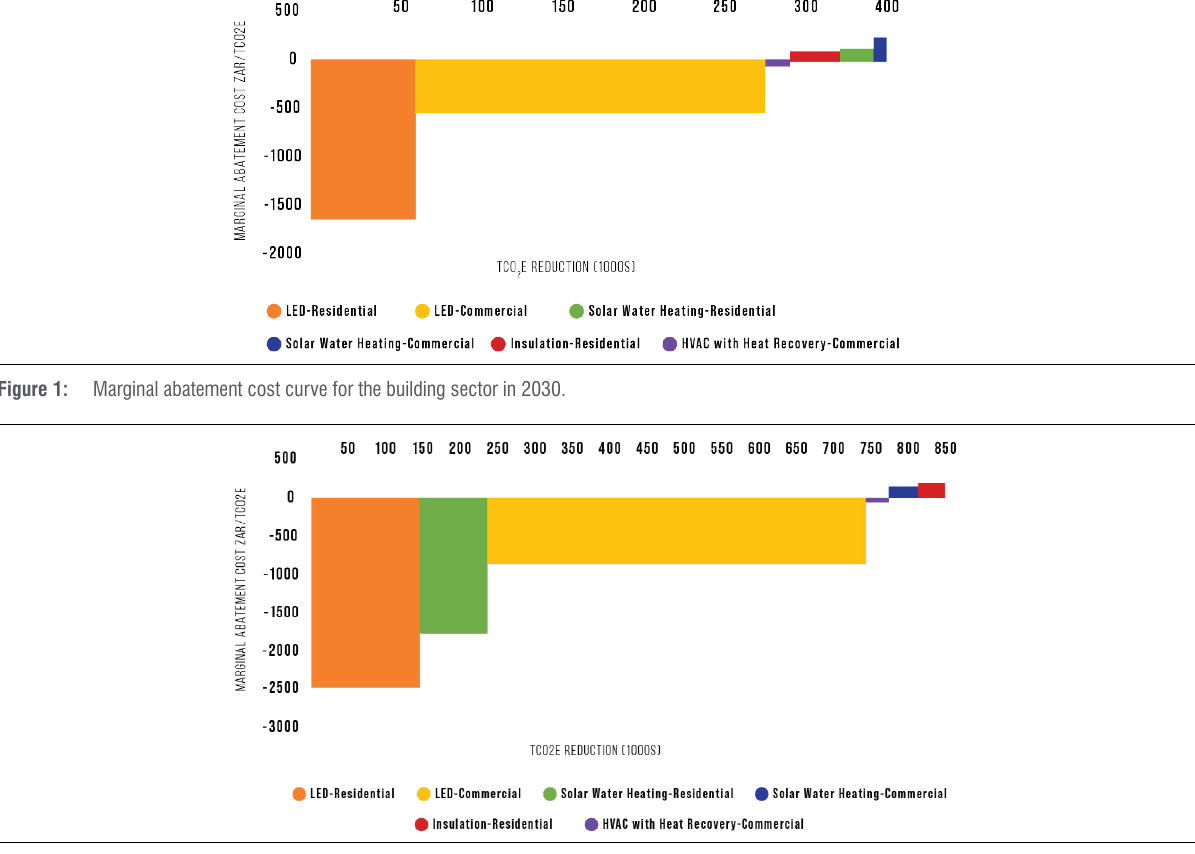
Figure 2: Marginal abatement cost curve for the building sector in 2040.